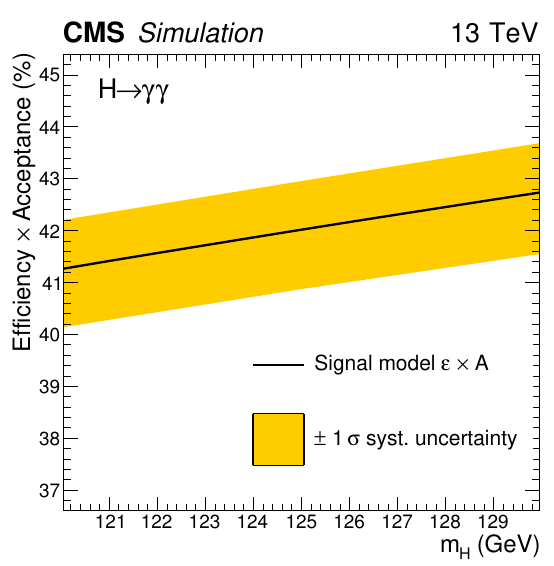
Figure 9 . The product of e(cid:14)ciency and acceptance of the signal model as a function of m H for all categories combined. The black line represents the yield from the signal model. The yellow band indicates the e(cid:11)ect of the (cid:6) 1 standard deviation of the systematic uncertainties for trigger, photon identi(cid:12)cation and selection, photon energy scale and modelling of the photon energy resolution, and vertex identi(cid:12)cation (described in section